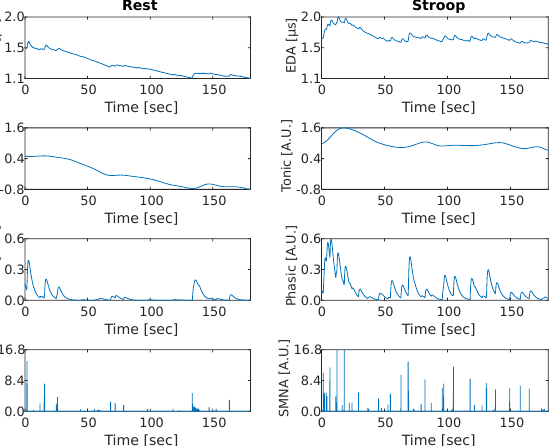
Figure 3. Thermal signals of one sample subject for each ROI in both rest and stress conditions. The tem- perature range of the plots was set equal for both conditions in each ROI, to allow visual comparison.